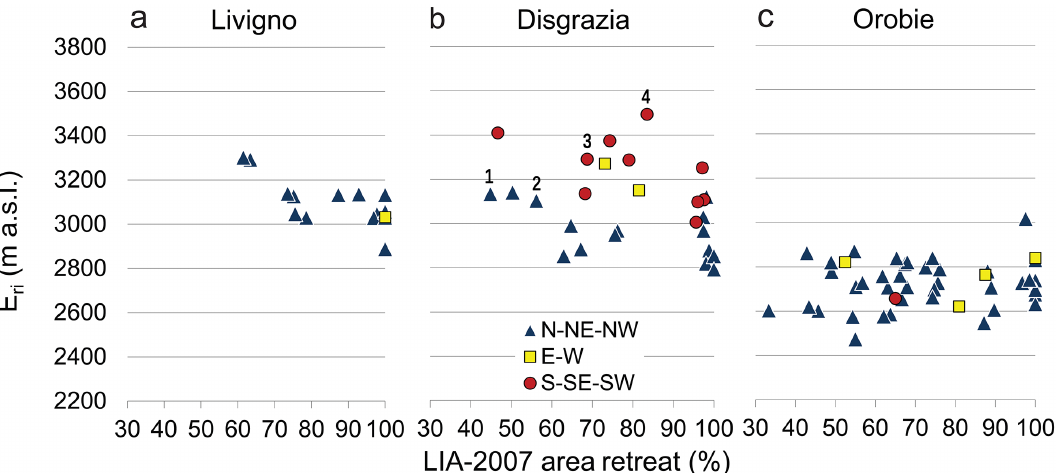
Figure 11. Relative area retreat in 1860–2007 as a function of E ri (ridge-crest elevation upslope of the glacier) in (a) Livigno, (b) Disgrazia, and (c) Orobie. Glaciers are stratified by the dominant slope aspect (note the different symbols). Numbers refer to the glacier cited in the text; 1: Ventina, 2: Disgrazia/Sissone, 3: Predarossa, 4: